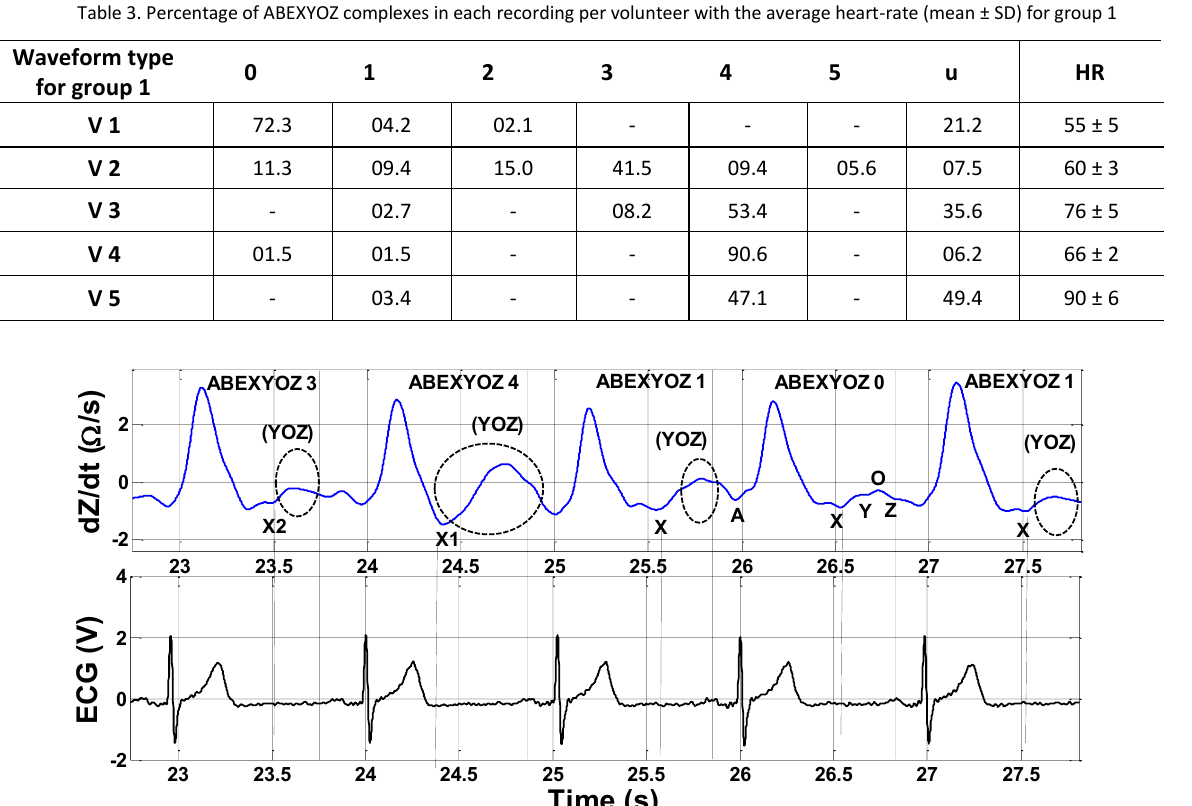
Fig. 6: Five consecutive ABEXYOZ complexes with different morphologies.